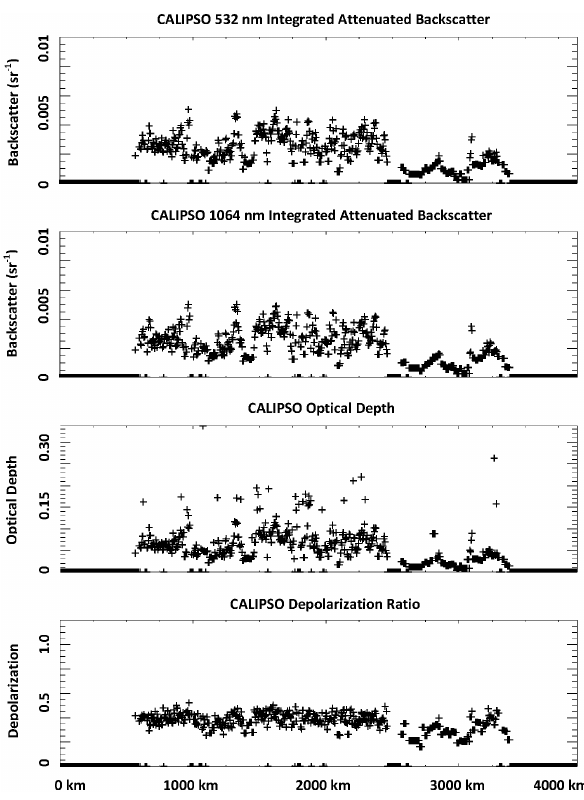
Fig. 2. Variation of the cirrus cloud parameters retrieved from CALIPSO at 15.5km, for the cloud shown in Fig. 1. The x-axis represents the horizontal distance along the cloud from North to South (scale: 1 unit = 5km).